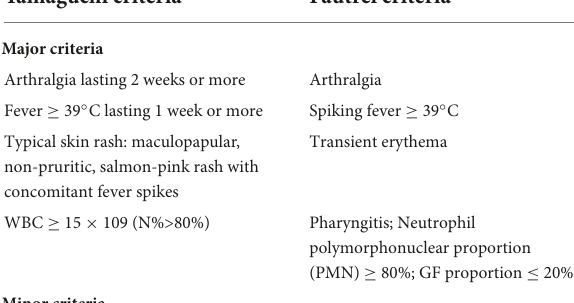
TABLE 2 Diagnostic criteria of